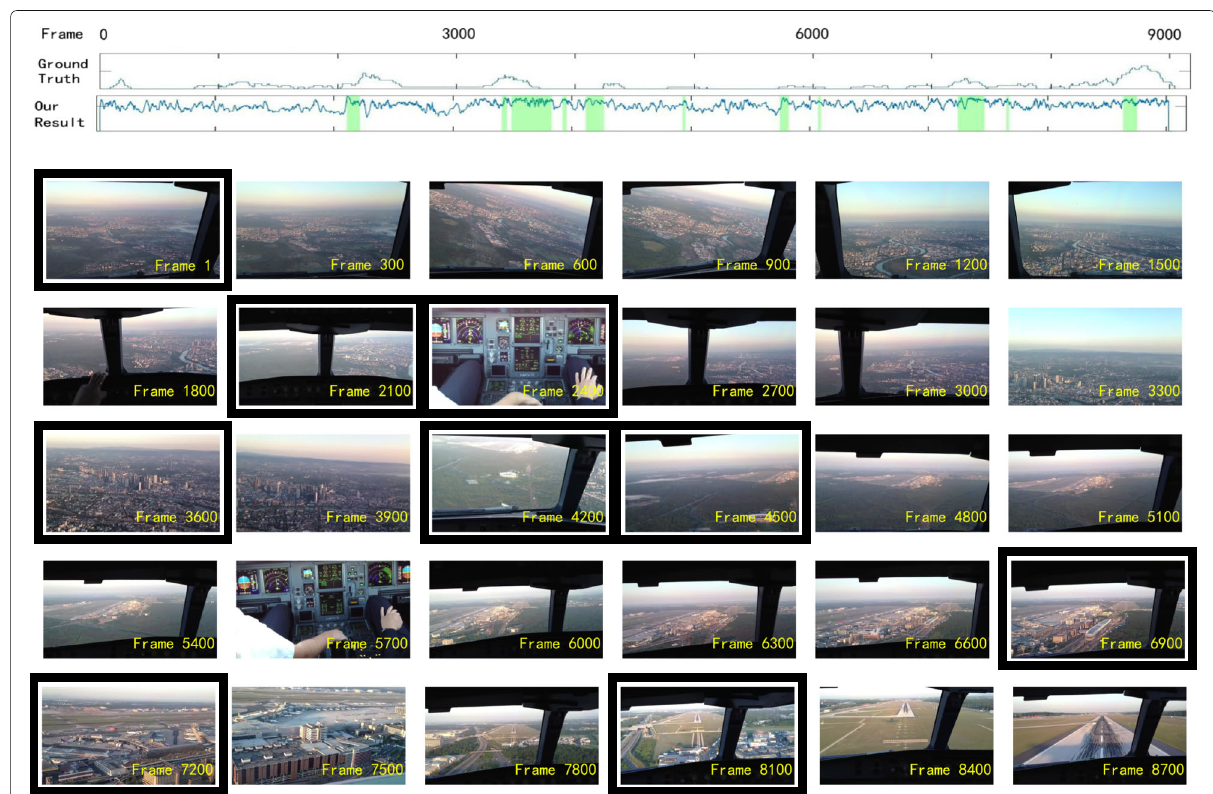
Fig. 5 Results for sample video summarization. We select 29 frames with fixed steps from “Cockpit Landing” video, while the automatically selected frames are highlighted by black